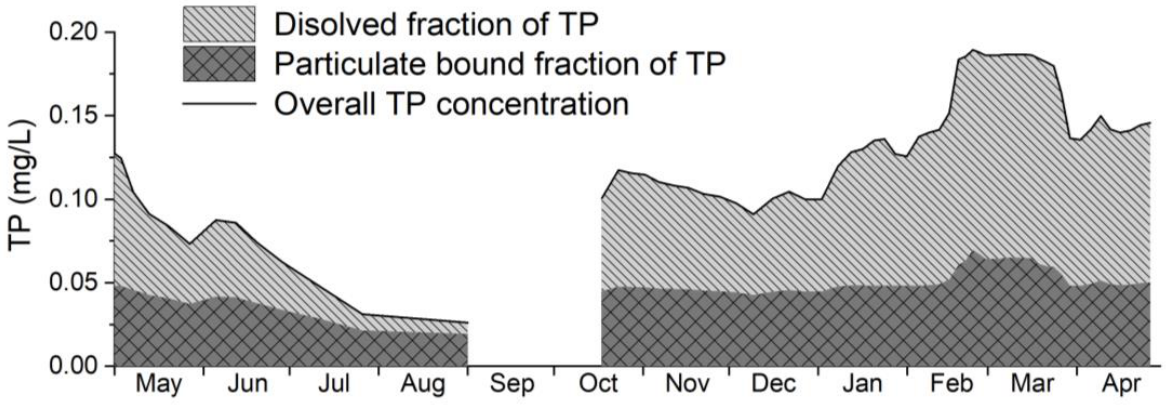
Figure 12. Average concentration of TP in the river during one year.